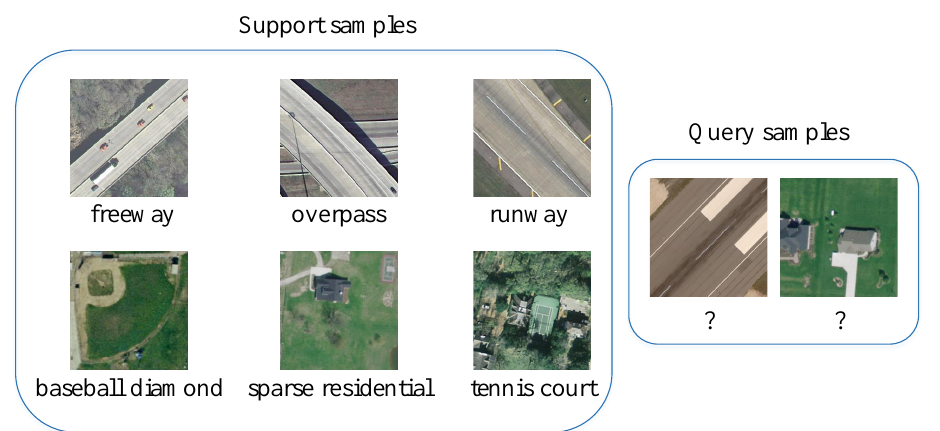
Figure 1. Illustration of few-shot remote sensing scene classification with only one labeled